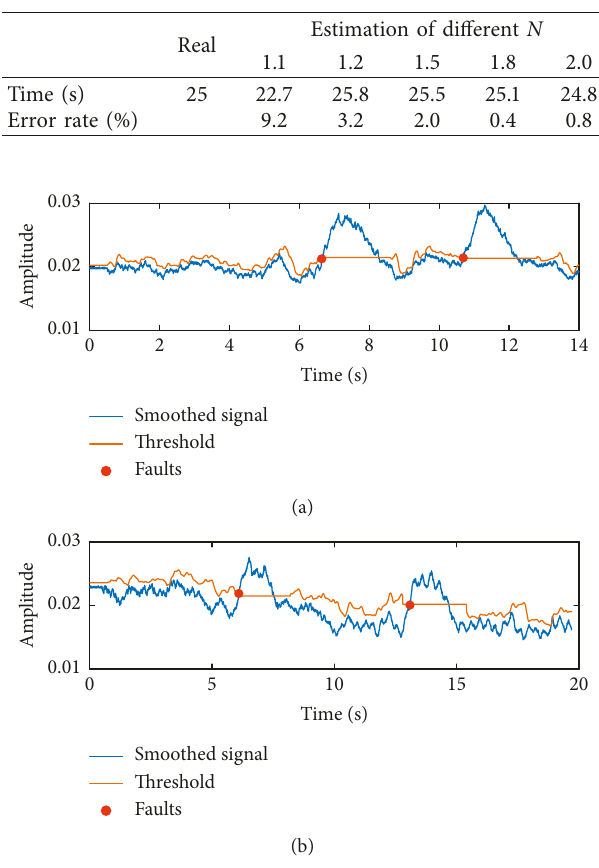
Figure 7: The results of a simulated case study: (a) original signal; (b) fault detection and fault time estimation. Table 2: Fault time estimation results.